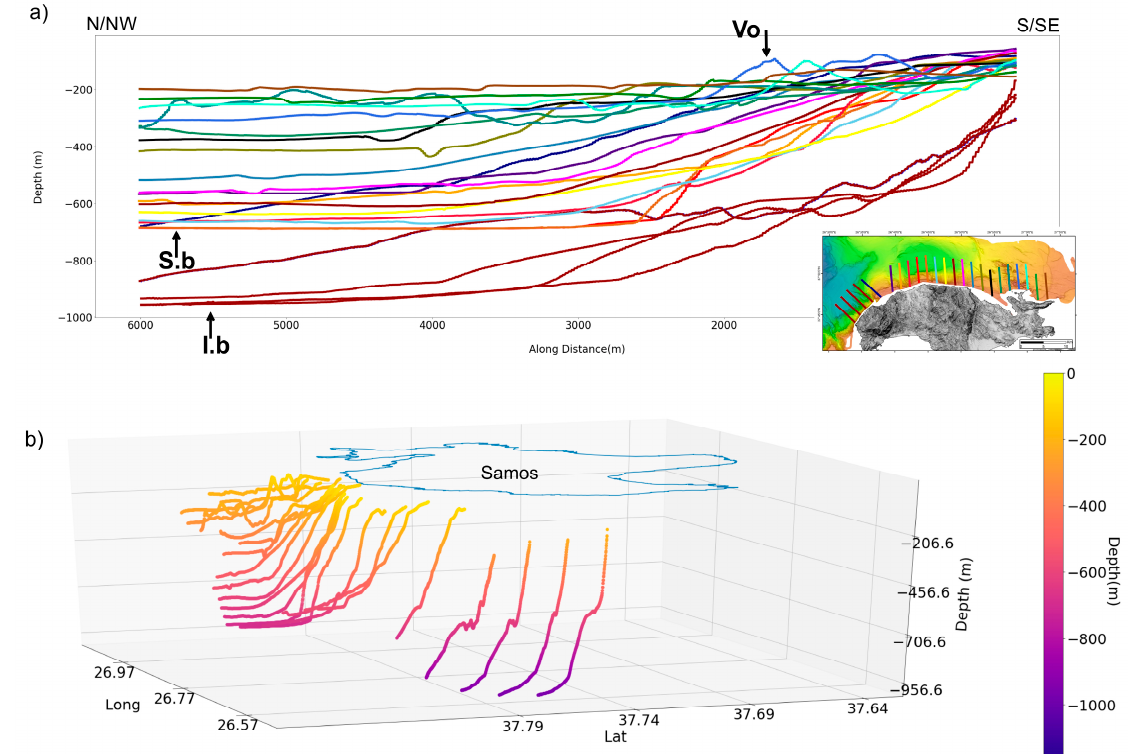
Figure 7. Parallel morphological profiles across the southern active margin of the Samos Basin. ( a ) Aligned profiles perpendicular to the Samos coastline. The four profiles in brown correspond to the Kerketeas NW–SE oriented profiles ending at the Ikaria basinal area (black arrow I.B.) at 950 m of depth. The rest profiles to the east with N–S orientation end down to the Samos basinal area at 600 m of depth (black arrow S.B.). The profiles show that the basin gets gradually shallower to the east. The hummocky relief stands out above the geometric sea bottom at the easternmost profiles, probably corresponding to volcanic rocks (Vo). ( b ) 3D view showing morphological profiles perpendicular to the Samos coastline. The deeper and steeper four profiles to the west correspond to the Ikaria Basin and the rest to the Samos basin, which gradually becomes shallower to the east.